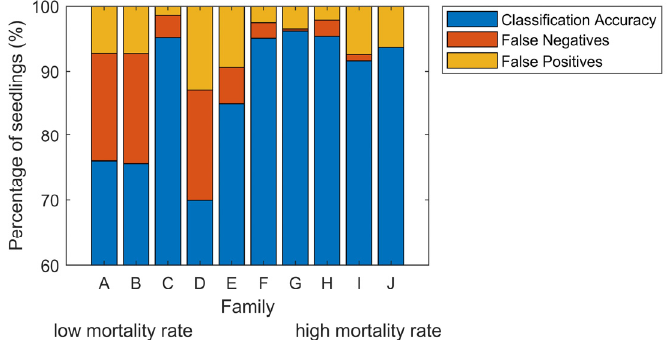
Figure 4. Mean classification results over 16 dates per family. The error (100%—Classification Accuracy) per family is explained in terms of false-negatives and false-positives. Families are ordered based on the mortality rate at the end of the experiment, the same as in Figure 1.